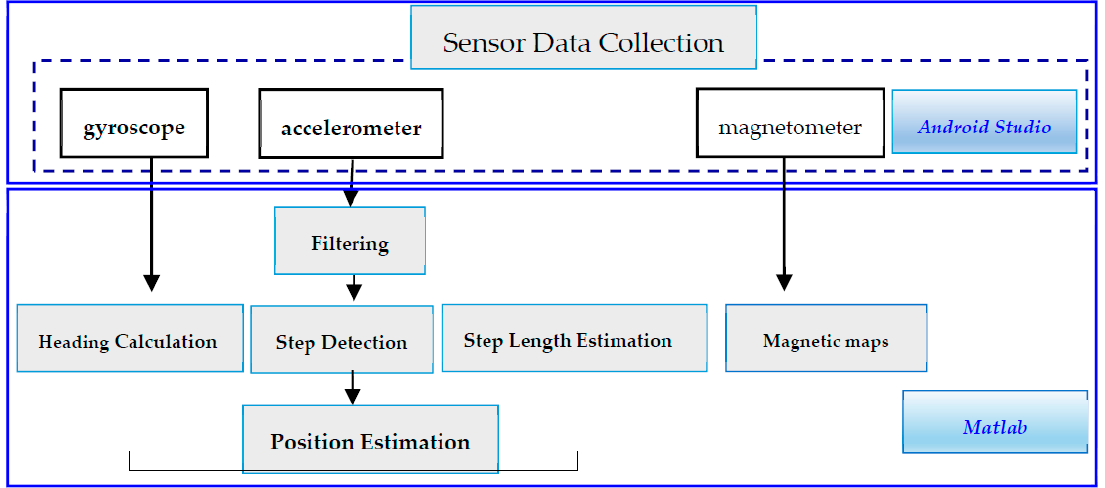
Figure 1. Sensors used in the structure involving the PDR algorithm and magnetic maps.